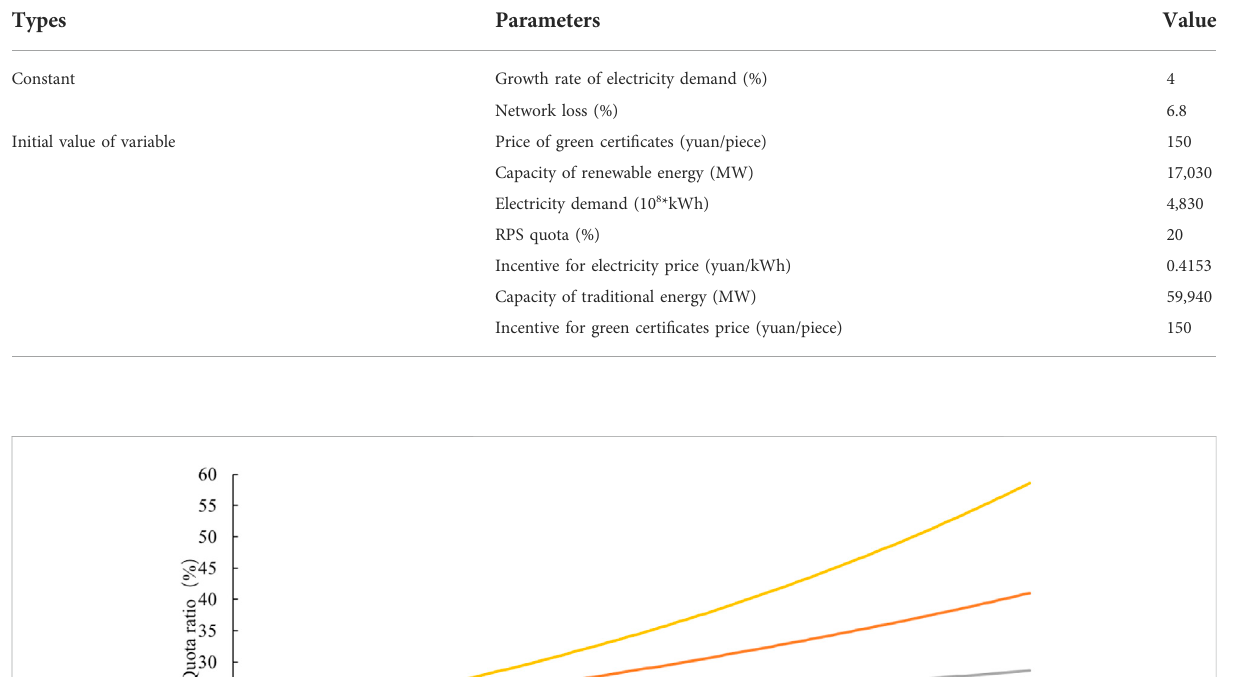
FIGURE 3 RPS quotas under three